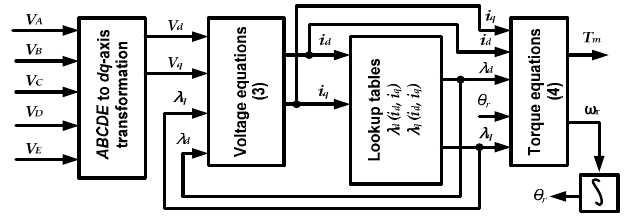
Figure 4. Five-phase SynRM block diagram with look-up tables.